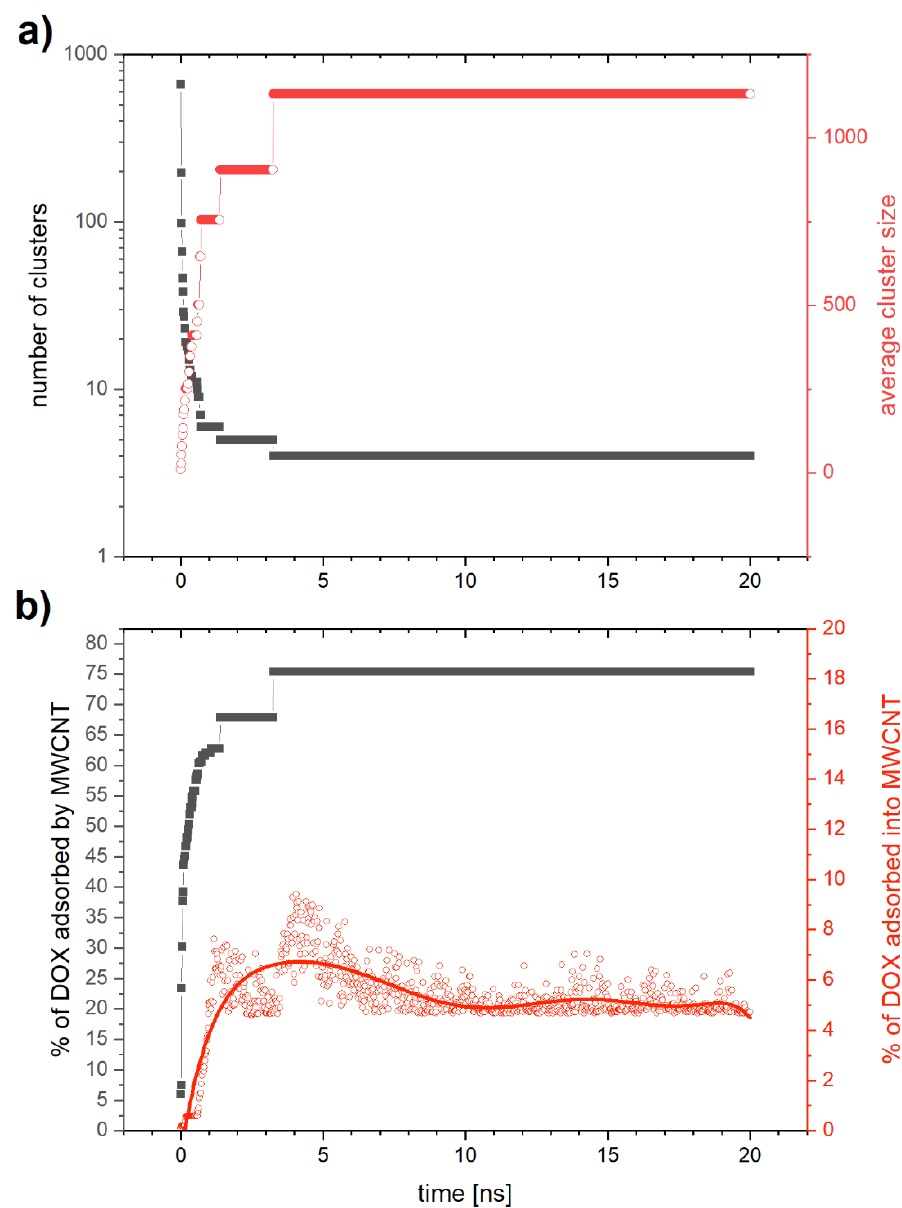
Figure 8. MD-simulated MWCNTs with DOX: ( a ) the number of clusters (gray) and mean degree of aggregation of single aggregate (red) as a function of time; ( b ) fraction of DOX molecules adsorbed on the multiwall carbon nanotube (gray), and that adsorbed inside the multiwall carbon nanotube (red) as a function of time.